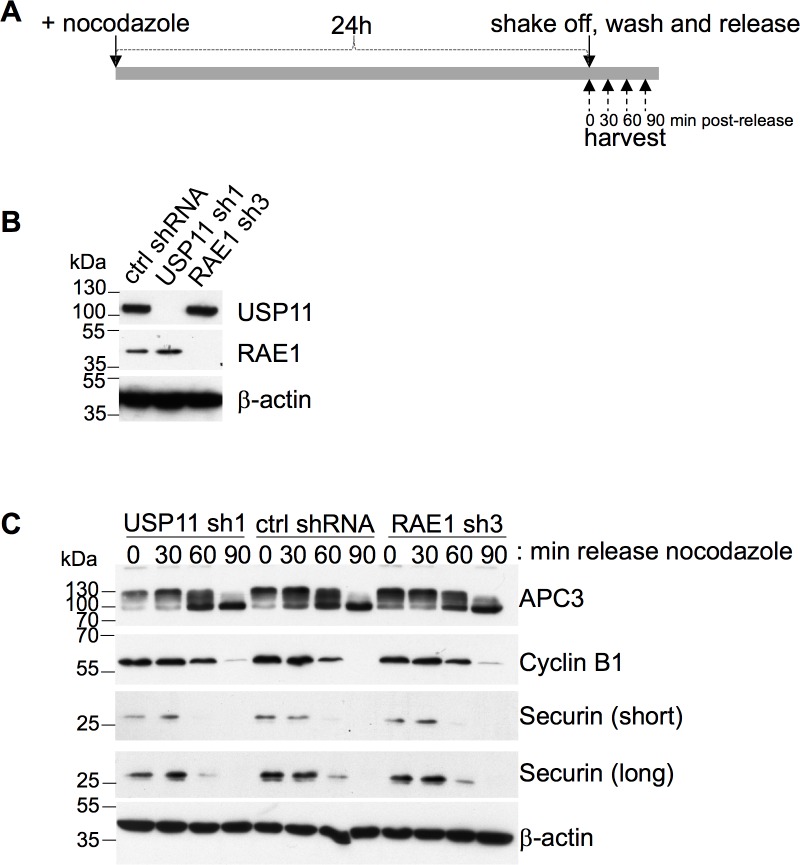
Knock-down of USP11 or RAE1 does not induce premature SAC inactivation.(A) Schematic representation of experimental workflow. U2OS cells expressing shRNA targeting USP11 or RAE1 transcripts were incubated for 24h with nocodazole. Mitotic cells were shaken off, washed and released from nocodazole arrest. Samples were taken at indicated time points post-release. (B) Western blot verification of USP11 and RAE1 knock-down. (C) Western blots illustrating the changes in cyclin B1 and securin protein levels upon knock-down of USP11 or RAE1 compared to control shRNA transduced cells. APC3 dephosphorylation was used as a marker for metaphase to anaphase progression. Antibodies used are indicated to the right of the western blots, molecular weight markers are indicated to the left of the western blot. shRNAs, and time upon release from nocodazole (min) is shown above the western blots. The data shown is representative of 3 biological replicates.